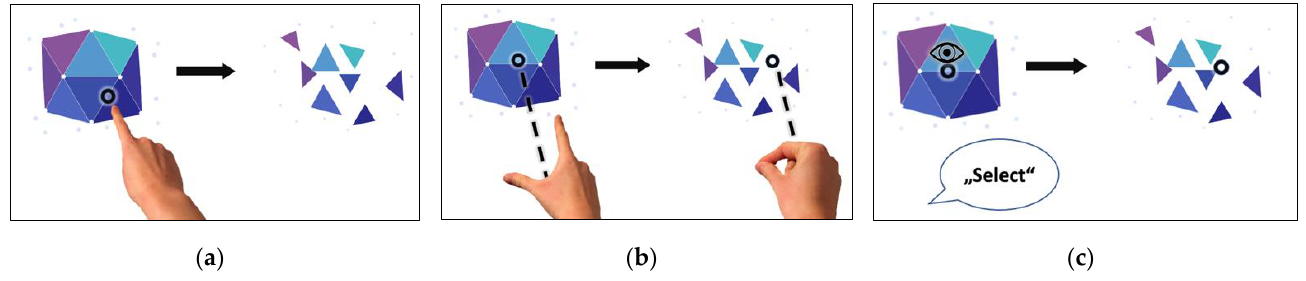
Figure 2. AR-interaction modes provided by HoloLens 2. ( a ) ‘tap’; ( b ) ‘air - tap’; ( c ) ‘voice command’.